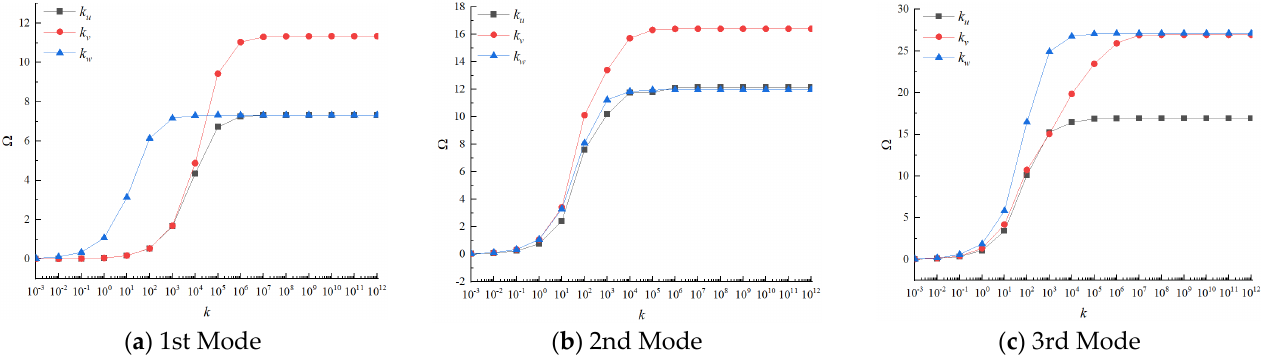
Figure 4. The geometric dimensions and the material parameters are as follows: 1 a b m = = , 0.05 h m = , and 1 p = . The boundary conditions of the plate are defined as: the edge y = 0 and y = b are completely free and the x = 0 and x = a are elastic supported by one group of spring constrain varying from 10 − 3 D c to 10 12 D c . From Figure 4, it can be seen that the non-dimension frequency parameters are unchanged and approaches 0 when the spring stiffness is smaller than 10 − 1 D c , and when the spring stiffness is varied from 10 − 1 D c to 10 7 D c , the frequency parameters increase rapidly. Finally, when the spring stiffness exceeds 10 7 D c , the frequency parameters will approach their utmost and tend to be stable. There- fore, we can arrive at the conclusion that the free boundary conditions and clamped boundary conditions can be simulated by assigning the spring stiffness value to be 0 or 10 7 D c.